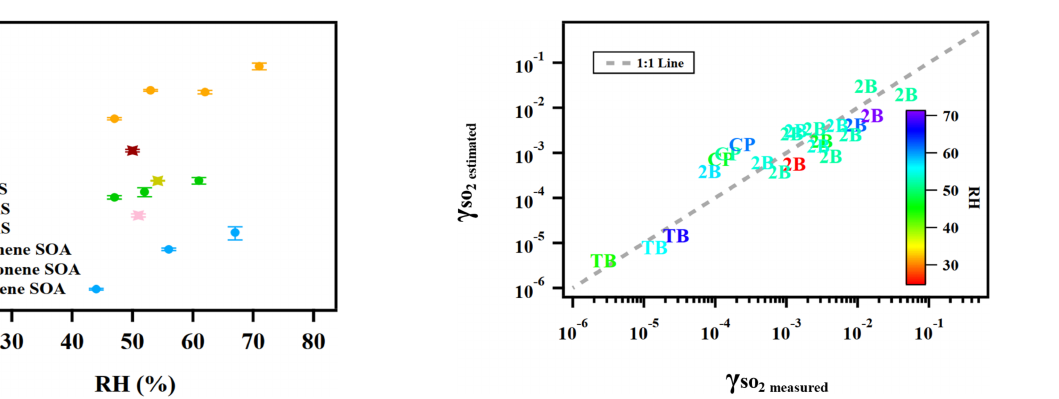
Figure 6. γ SO measured for different types of organic aerosol. The 2 reactive uptake coefficient of SO 2 onto SOA is on the order of 10 − 4 .